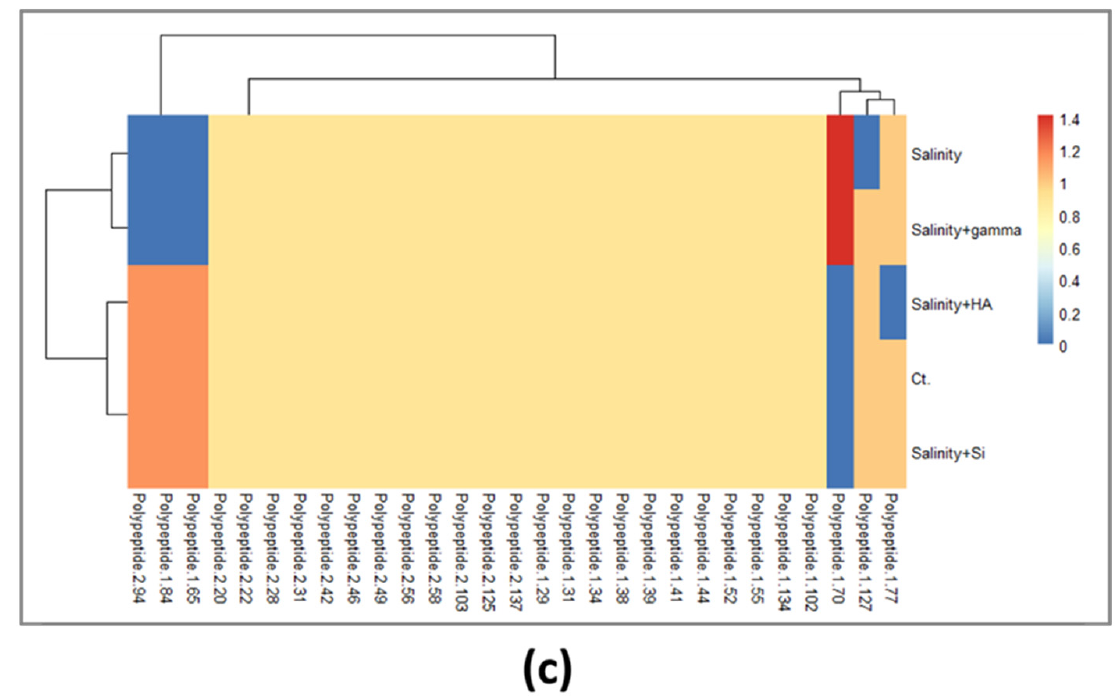
Figure 3. ( a ) Differential expression of RuBisCO LS protein as revealed by salinity stress. Y axis values represented the differentially expressed RuBisCO LS . The data were expressed as the mean ± s.e.m. *, p < 0.05. Quantification of the RuBisCO large subunit (RuBisCO LS ) protein band using ImageJ